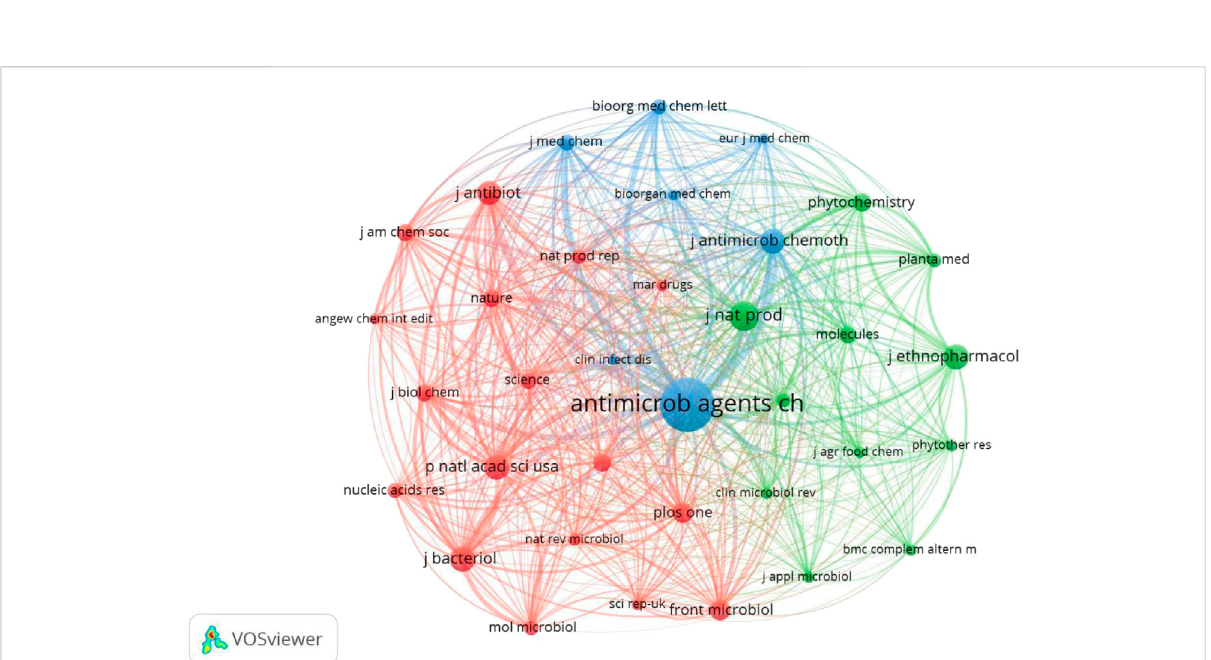
FIGURE 6 Network visualization map of co-cited journals related to resistance of natural products to MDR